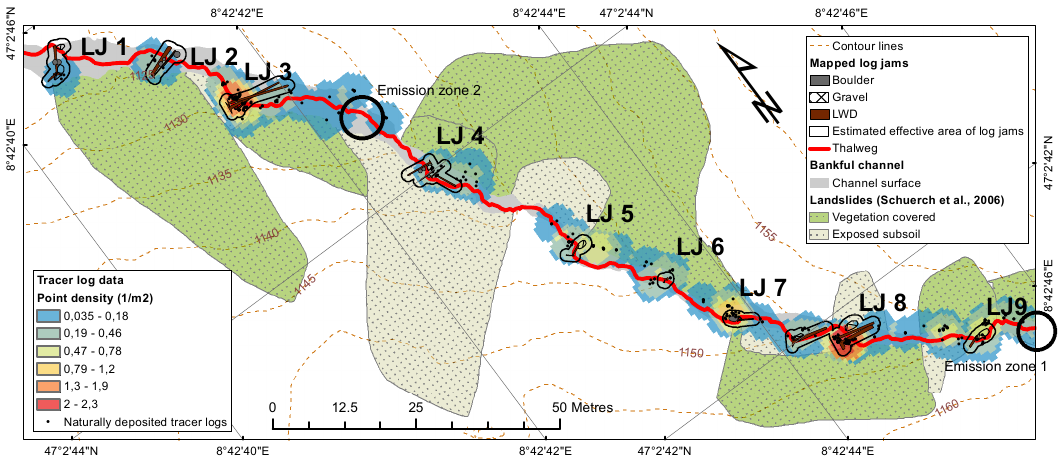
Figure 4. Map of the study reach including visualizations of the log jams (LJ1 to LJ9, cf. Table 3) and the point densities of naturally deposited tracer logs. The effective area of LJs was estimated by adding a buffer of 1m around the mapped LJ perimeter to account for survey inaccuracy.